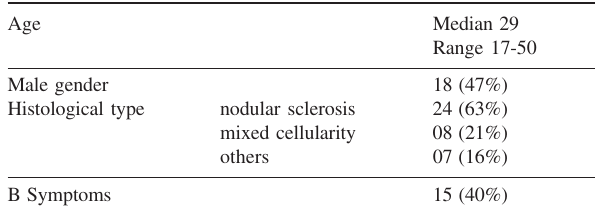
Table 1 - Patient Characteristics